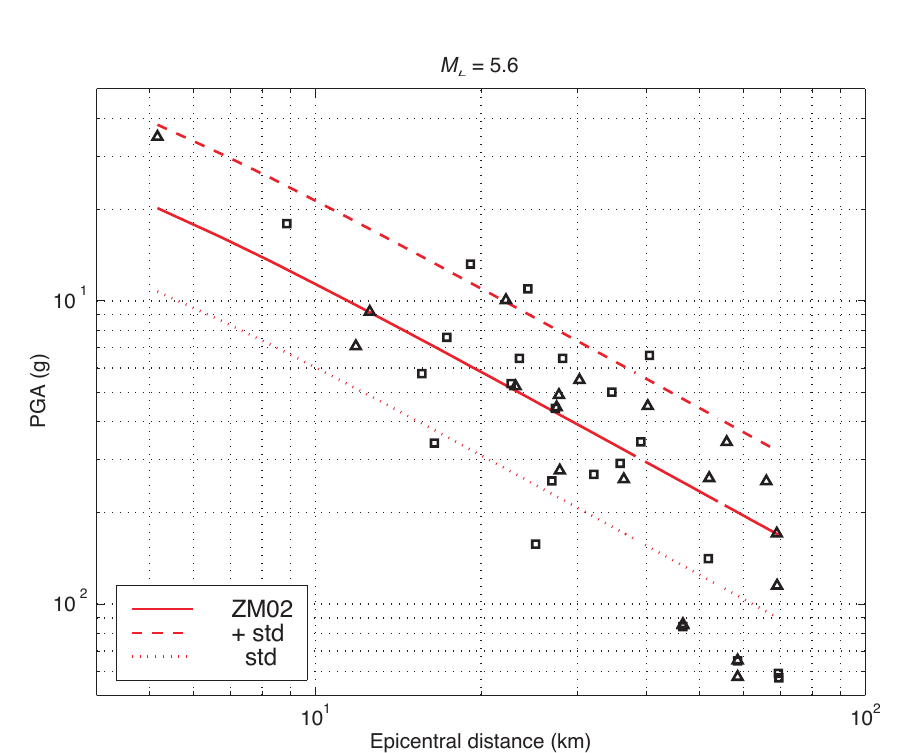
Fig. 8. Peak Ground Acceleration attenuation function is plotted with respect to epicentral distance for local magnitude M = 5.6 (solid line), while the dashed and the dotted lines are respectively PGA attenuation relationship L plus or minus one standard deviation. The black symbols represent the observed PGA: squares are for rock sites, triangles for soils (see table